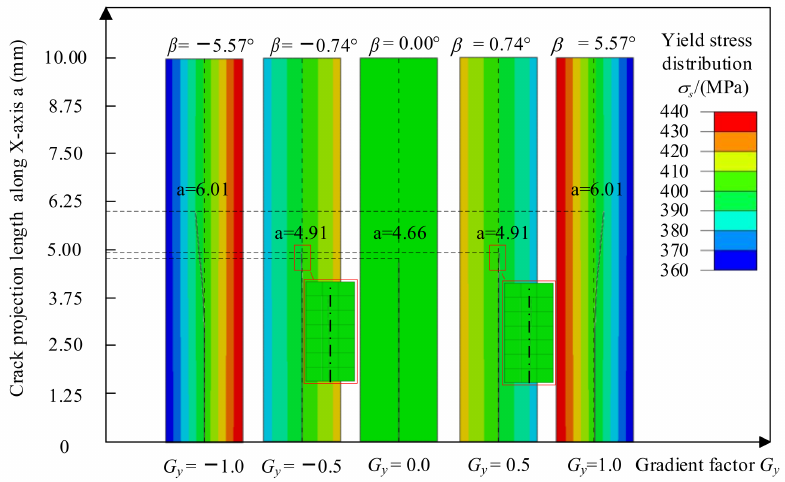
Figure 15. Crack propagation path in the direction of vertical crack yield strength